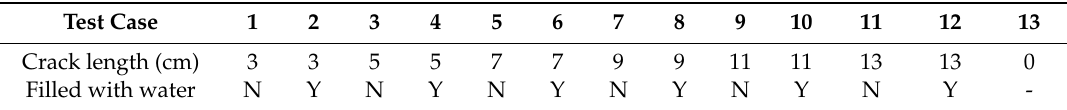
Table 2. The 13 test cases.